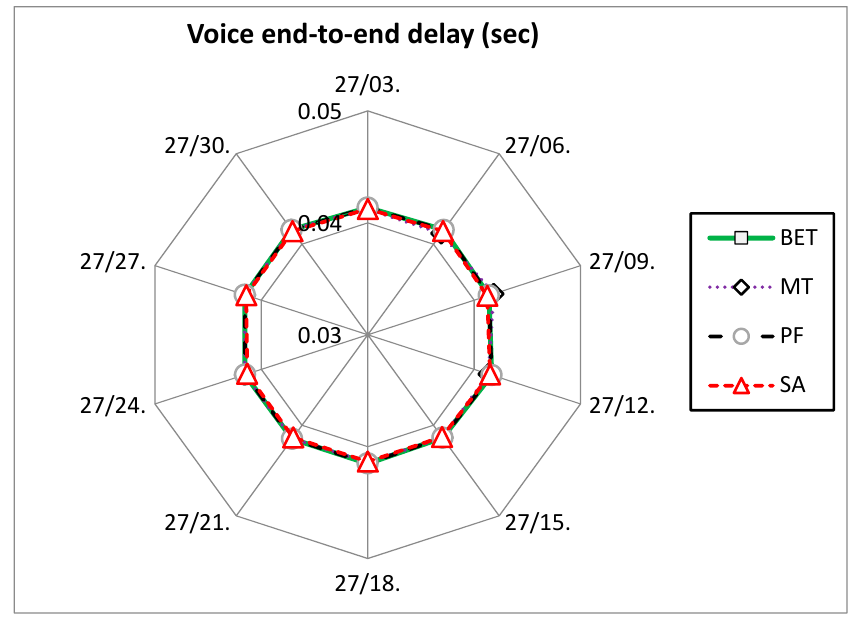
Figure 7. Average packet end-to-end delay for voice near users in mixed traffic.